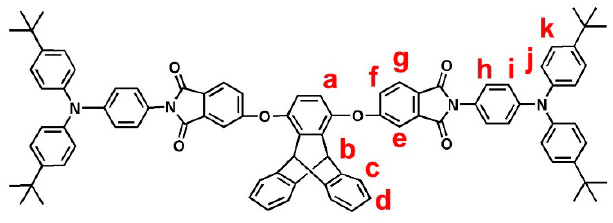
Figure 3. Structure and codes of hydrogen atoms of M1.